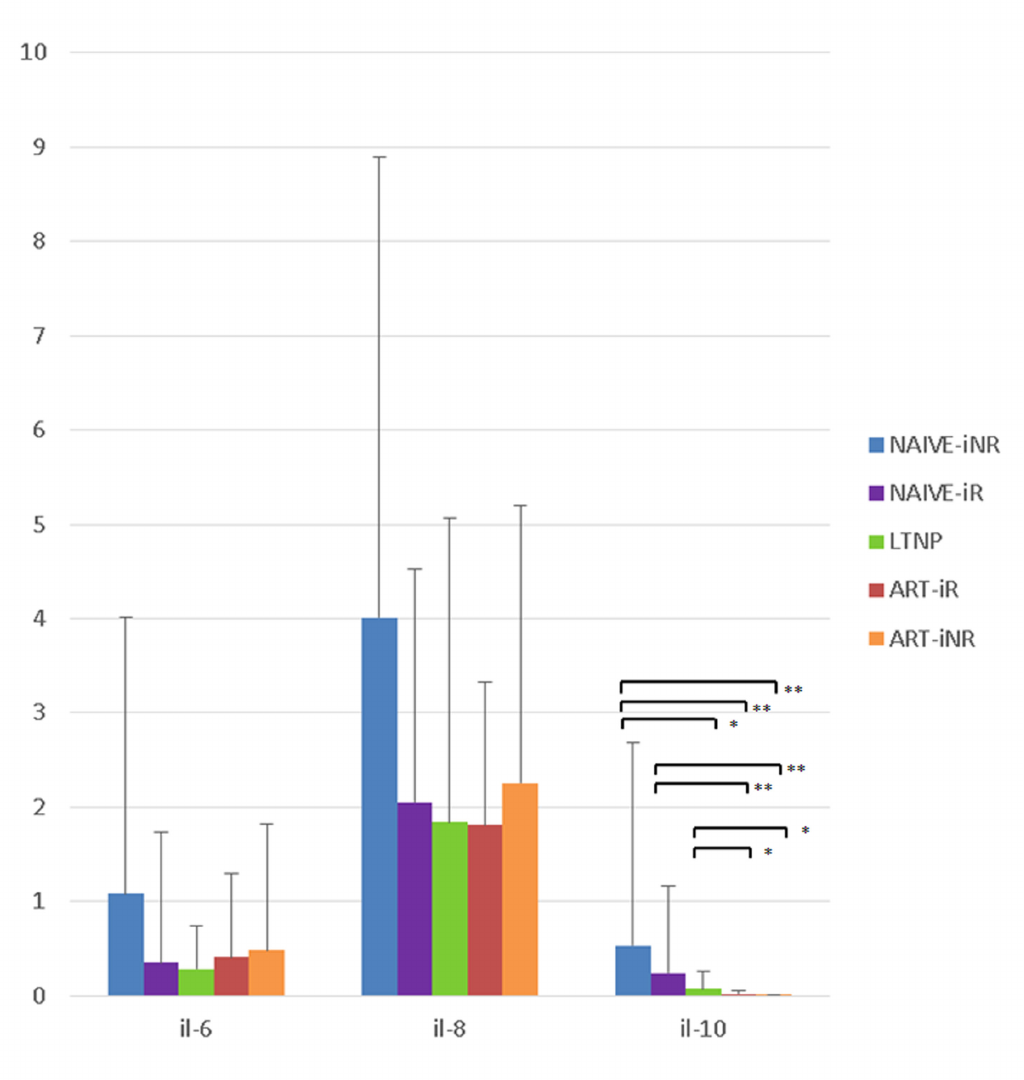
FIGURE 4 - Cytokines values in the five HIV-infected groups. Significant difference between the specified groups: * ≤0,05, ** ≤0,01. Gamma test was used for all cytokines. ART: antiretroviral therapy; Naïve: ART-naïve; iR: immunological responder; iNR: immunological non-responder; LTNP: long-term